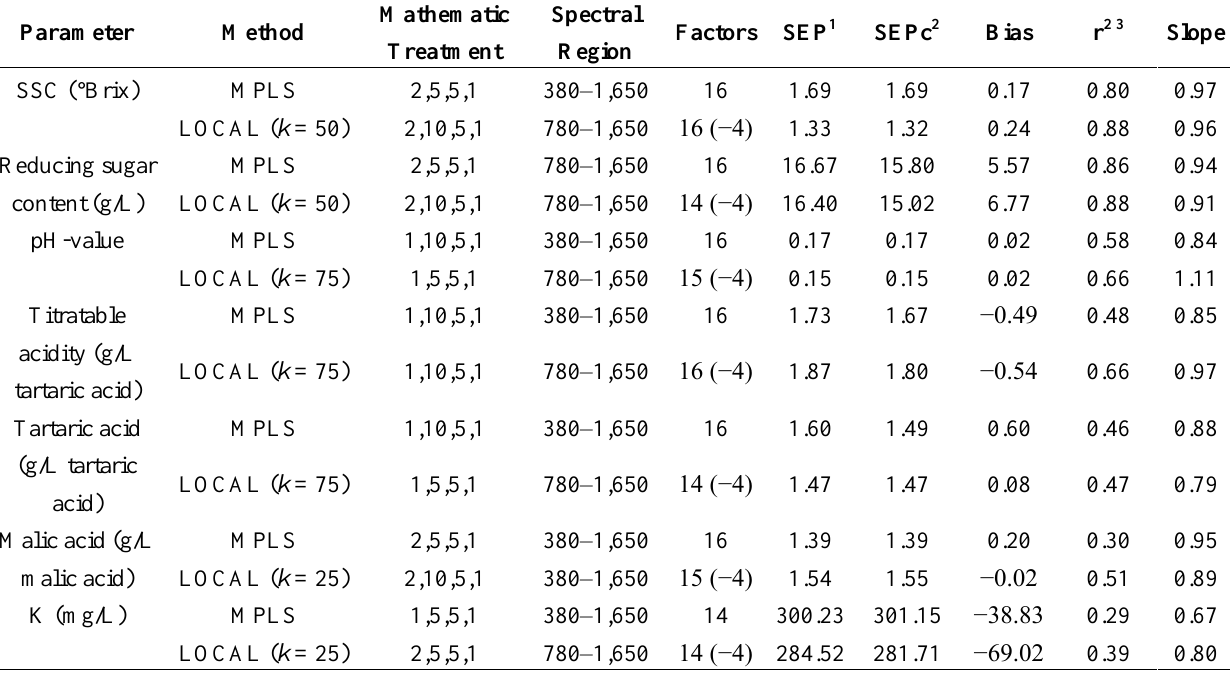
Table 3. Validation statistics for the best models for predicting soluble solid content (SSC), reducing sugar content, pH-value, titratable acidity, tartaric acid, malic acid and potassium content using MPLS and LOCAL